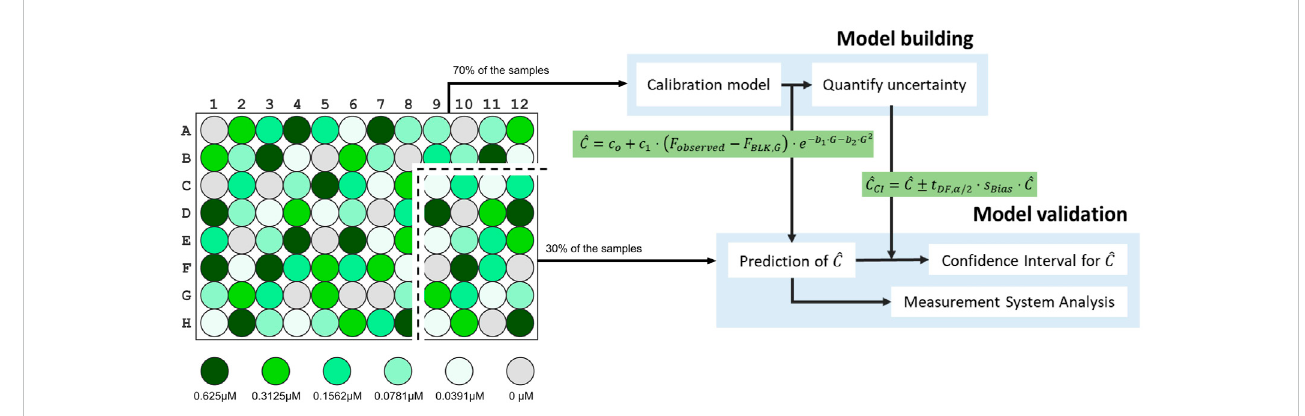
FIGURE 2 Schemarepresentingtheassessmentontheproposedmodeldonebyamodelbuildingandamodelvalidationstep.Particularly,elevenoutofthesixteen wells ( ≈ 70 % ) for each concentration level were randomly selected for the Model Building step, and the rest were used for the Model